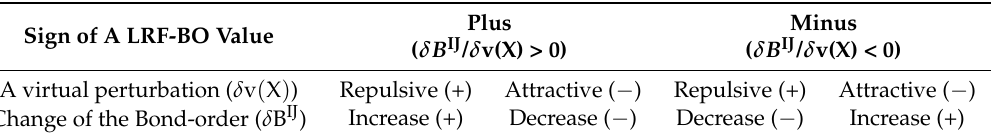
Table 1. Relation among the sign of LRF-BO, the sign of the perturbation, and the change of the bond-order.